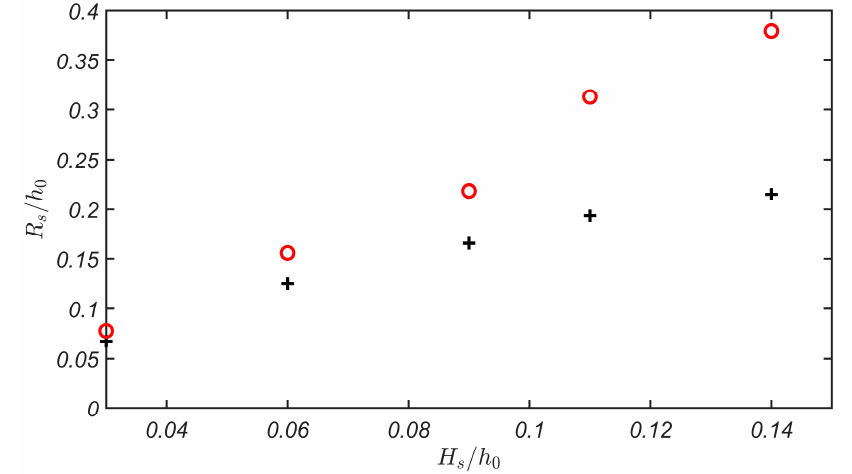
Figure 3. Probability density functions of normalized trough-to-crest wave heights of the initial narrow-band ( a ) and ( c ), and wide-band ( b ) and ( d ) wave fields for di ff erent nonlinearities, H s / h 0 in linear (top) and logarithmic (bottom) scales. The red solid line corresponds to the Rayleigh distribution; the black solid line corresponds to the Weibull distribution fitted to the corresponding dataset.